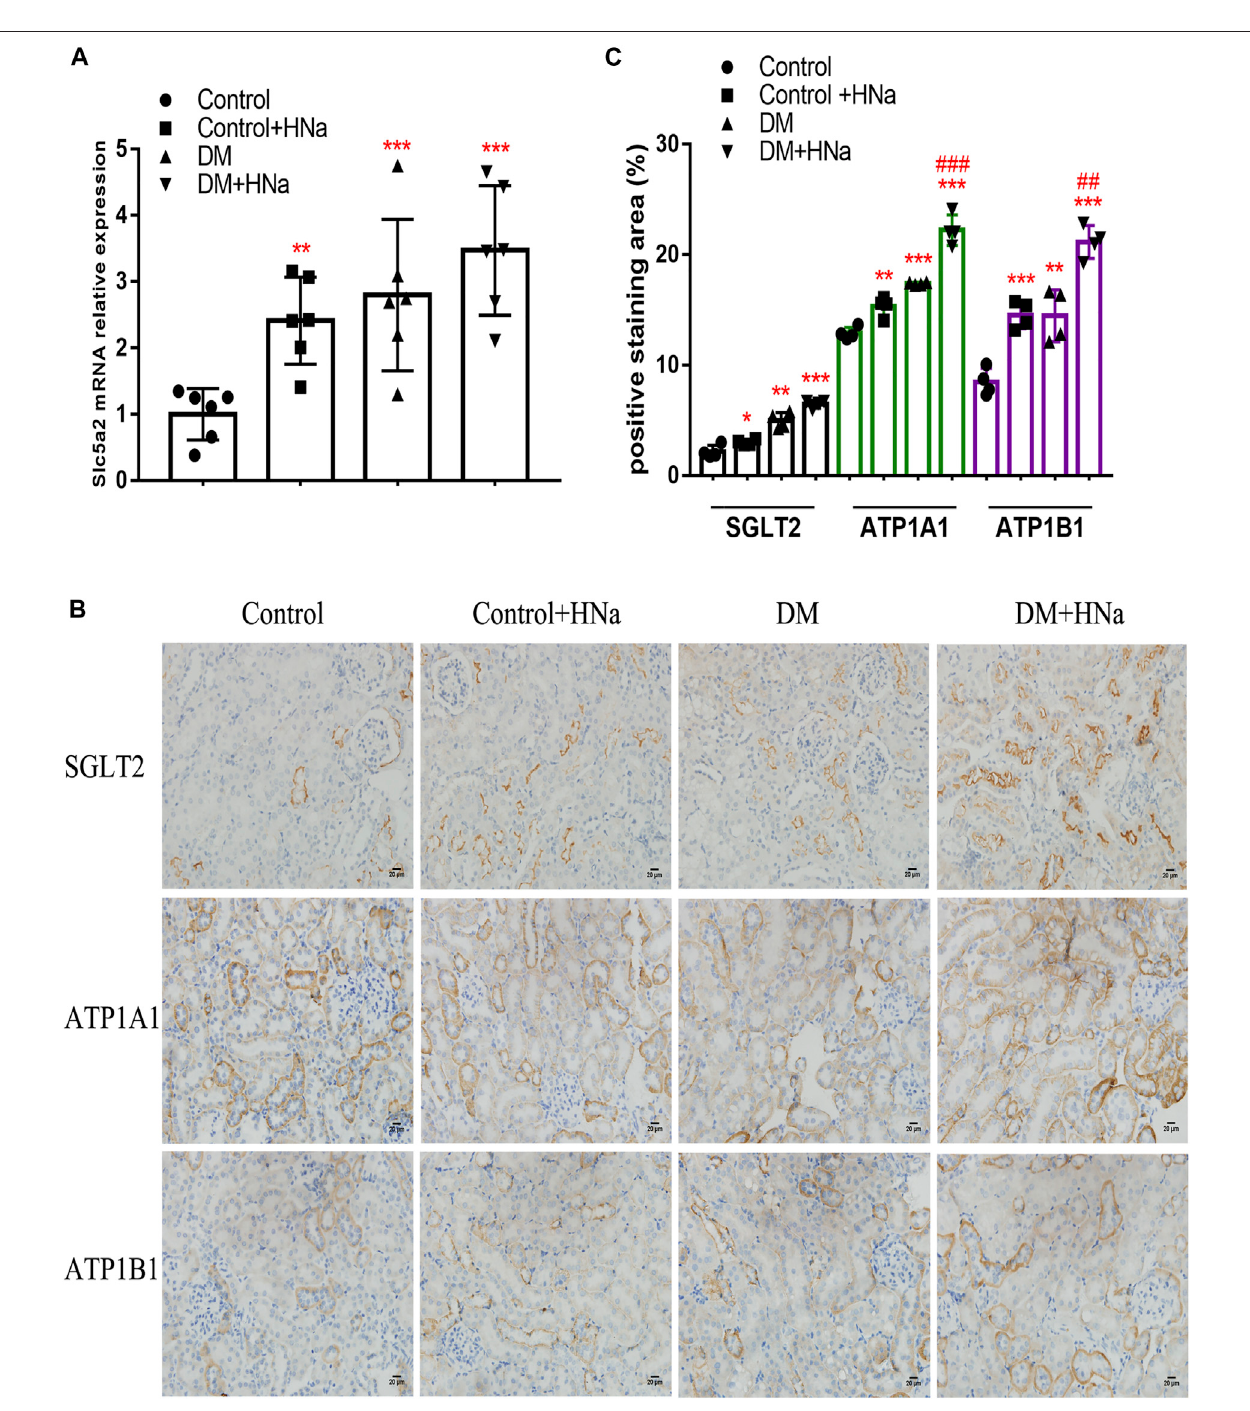
FIGURE 5 | High-salt diet alters SGLT2 and Na+/K + -ATPase expression in renal tubules of DKD mice. (A) Expression of SGLT2 gene in renal tubules ( n (cid:1) 6 per group). (B) Paraf fi n-embedded renal sections were stained with SGLT2, ATP1A1 and ATP1B1 antibodies (magni fi cation, 400 × , bar (cid:1) 20 μ m). (C) Histopathological assessment of SGLT2, ATP1A1 and ATP1B1 proteins ( n (cid:1) 4 per group). All data are mean ± SEM, * p < 0.05, ** p < 0.01 and *** p < 0.001 vs. Control group; ## p < 0.01 and ### p < 0.001 vs. DM group.